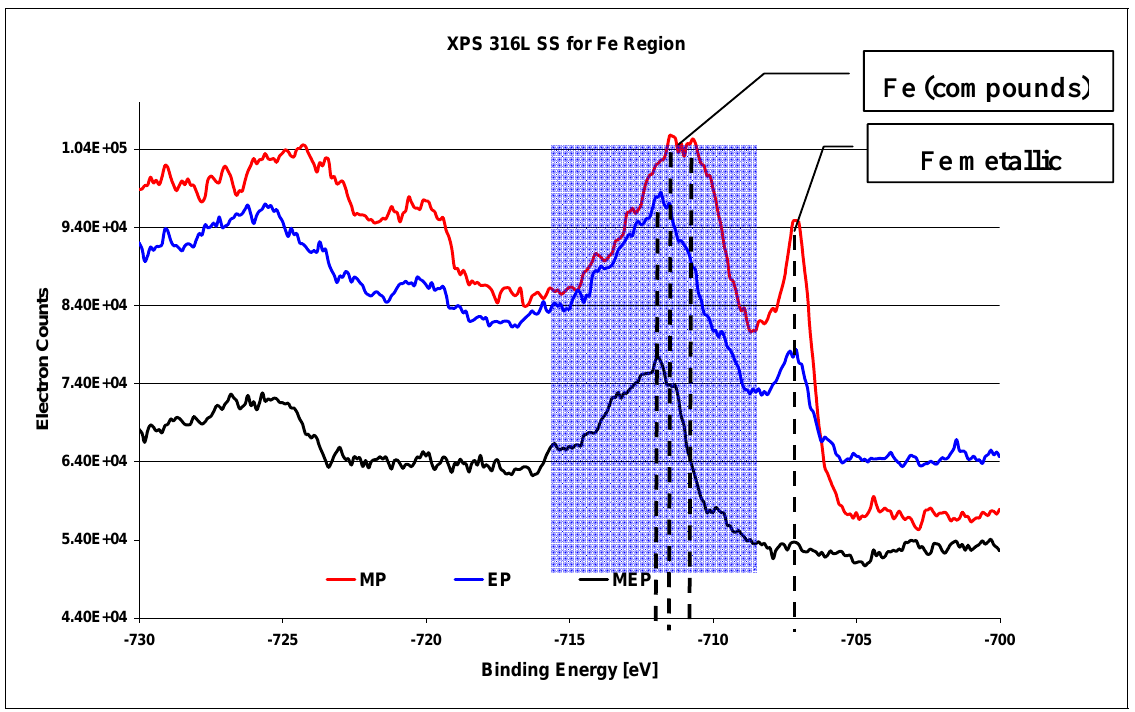
Figure 9. XPS results for Fe region of 316L SS surfaces after: MP – abrasive polishing, EP – standard electrolytic polishing, and MEP – magnetoelectropolishing [26].